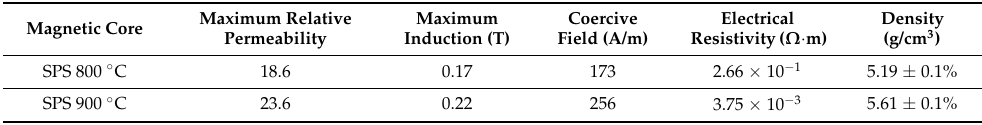
Table 1. DC magnetic characteristics of toroidal magnetic cores and their electrical resistivity and density. Magnetic